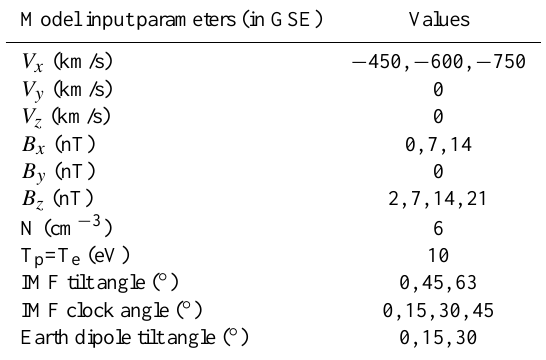
Table 1. Model input parameters for different model runs in this PDL dependence